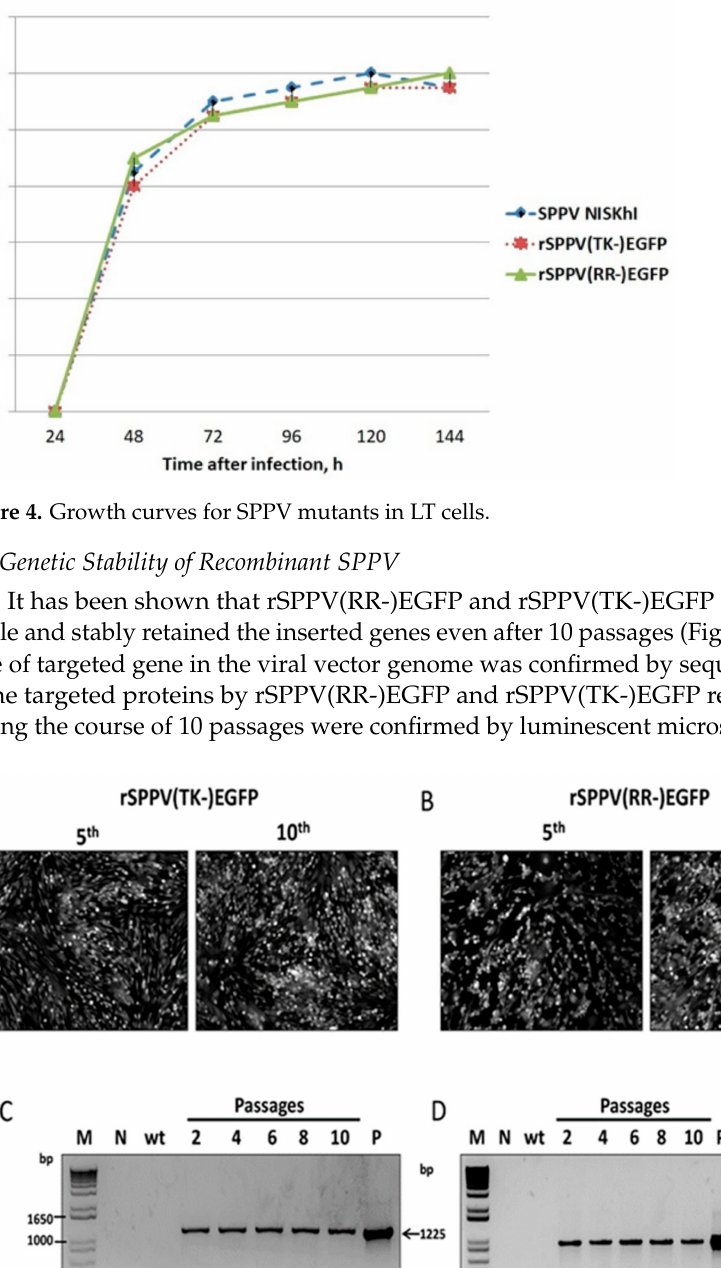
SPPV NISKHI (Figure 4).